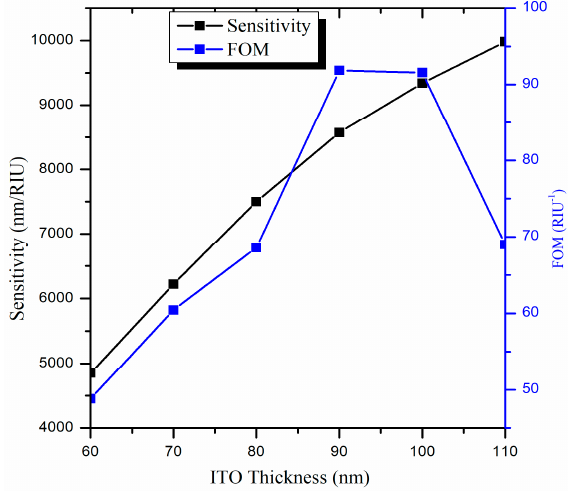
Figure 6. One can see that the FOM increases with the increase in thickness, attains a max- imum value at 90 nm, and then decreases rapidly. As a result, the thickness of the ITO film is optimized to 90 nm for the proposed U-shaped fiber optic LMR sensor. For this thickness, the sensitivity, FWHM, and FOM are detected to be 8570 nm/RIU, 93.3 nm, and 91.85 RIU − 1 , respectively. In the next section, the sensing region length (L) will be opti- mized for the designed U-shaped fiber optic LMR sensor.